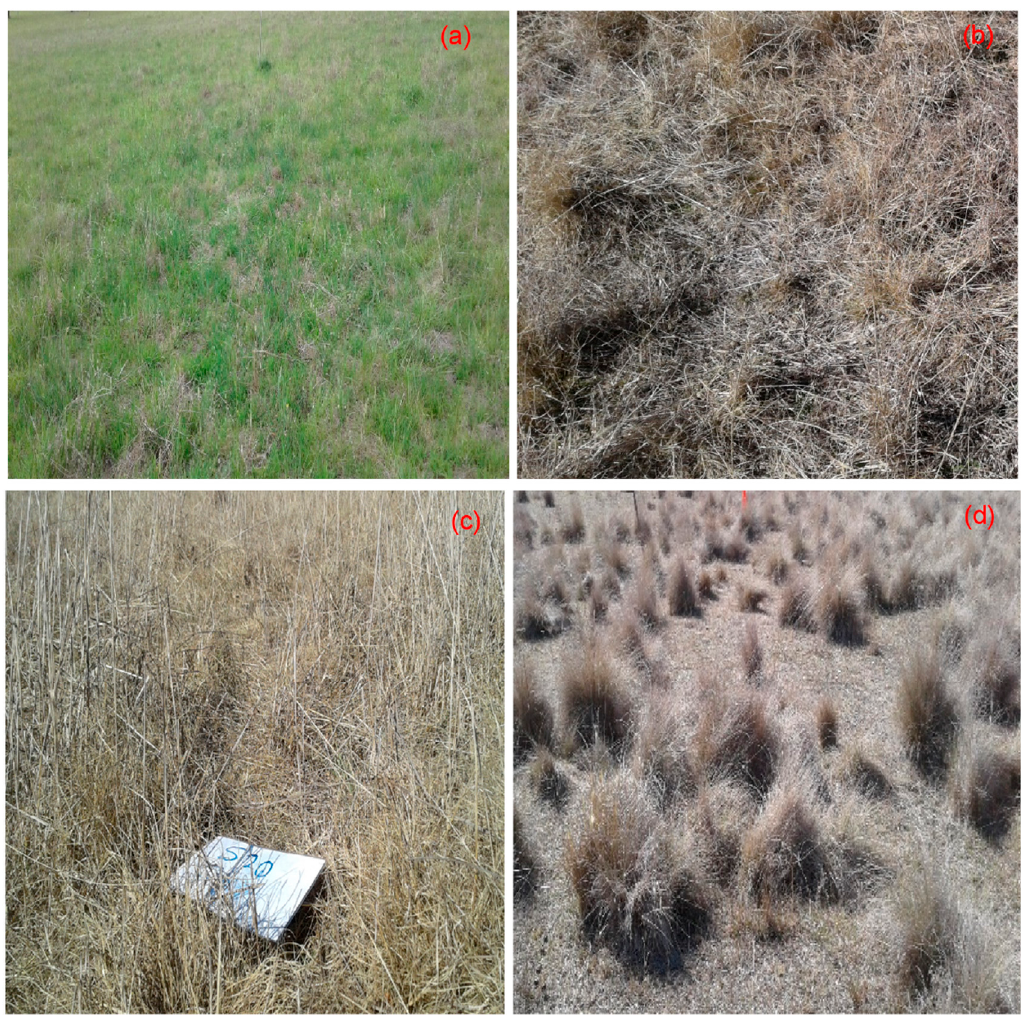
Figure 7. Some photos of the sampling sites: ( a ) growing period in summer, ( b ) dry period in winter, ( c ) grazed C4 site, and ( d ) grazed C3 site with evidence of preferential grazing between palatable and unpalatable species.